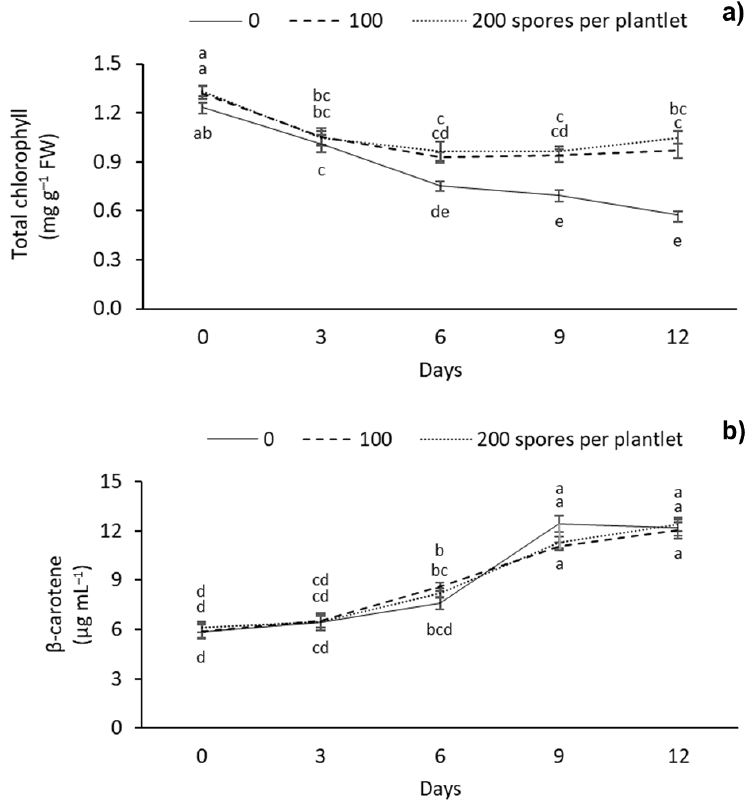
Figure 4. Effect of different doses (0, 100, and 200 spores per plantlet) of arbuscular mycorrhizal fungi ( Glomus intraradices ) on sugarcane plantlets ( Saccharum spp. cv Mex 69-290) evaluated under drought stress during acclimatization stage. ( a ) Total chlorophyll and ( b ) β -carotene. Results are shown as mean ± standard error. Means with different letters (a–e) are significantly different (Tukey, p < 0.05).